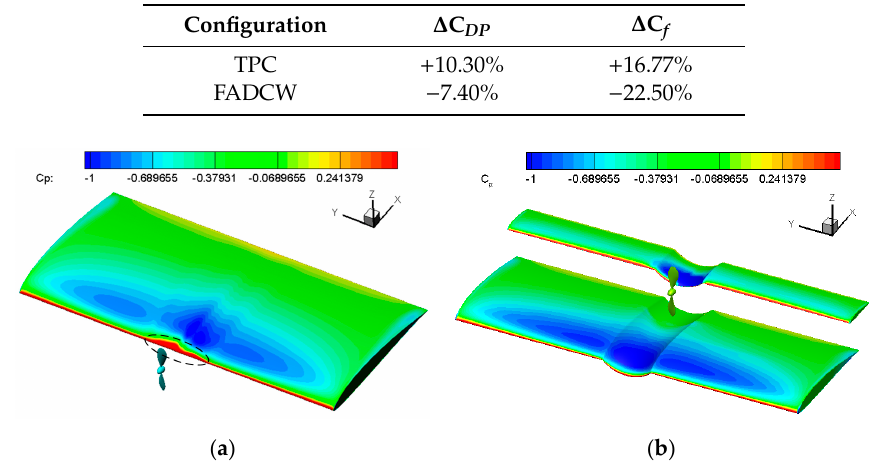
Table 4. Comparison of drag coe ffi cient between the TPC and FADCW. ( Ma = 0.1017, Ω = 4400 r/min, α = 2 ◦ , medium grid).